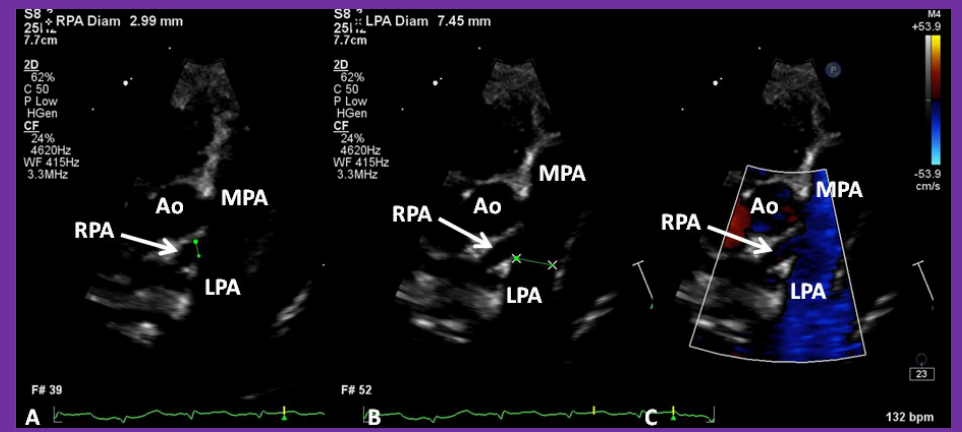
Figure 35. Selected video frames from parasternal short axis view demonstrating hypoplsia of the right pulmonary artery (RPA) in two dimensional ( A , B ) and color flow ( C ) images. The measurements of the RPA ( A ) and left pulmonary artery (LPA) ( B ) are shown. Ao, aorta; MPA, main pulmonary artery.